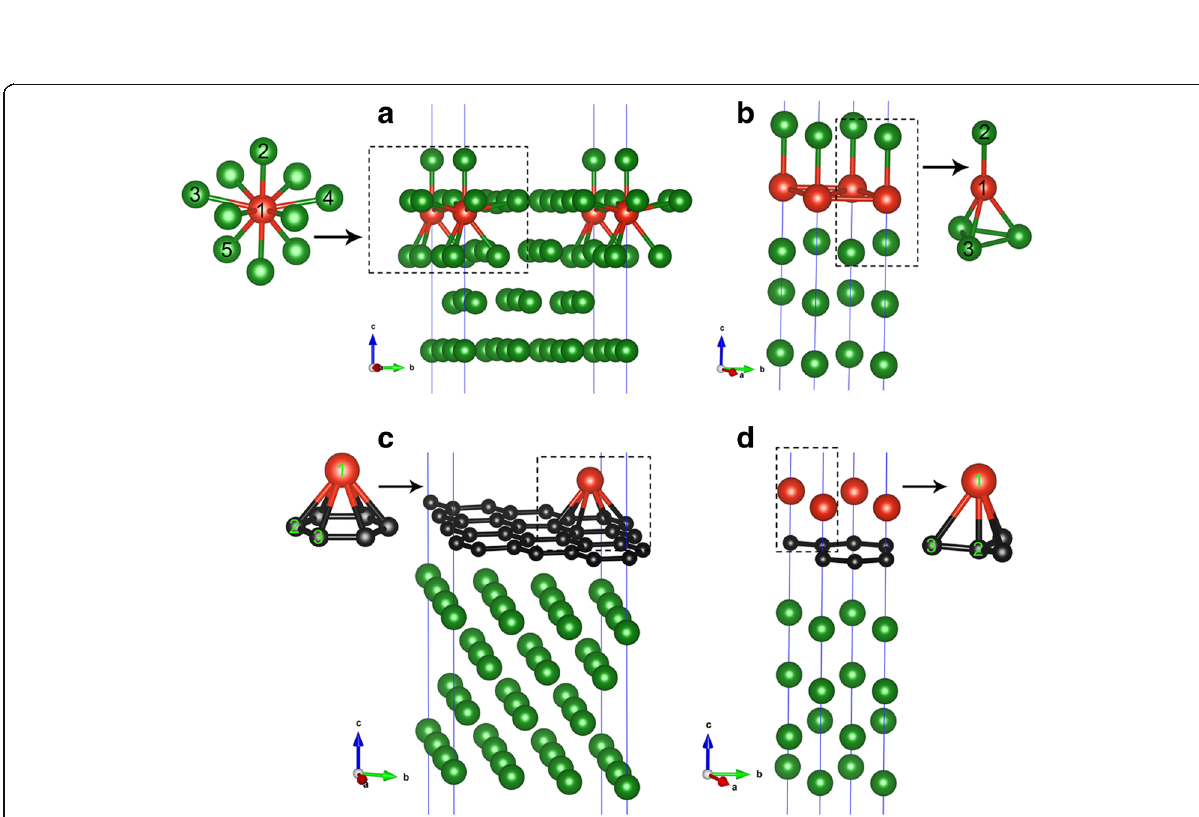
Fig. 2 Geometries of V/Cu(111) systems for a 1/9 ML and b 1 ML coverages. Geometries of V/Gra/Cu(111) systems for c 1/9 ML and d 1 ML coverage of V atoms. Red, black, and green balls represent V, C, and Cu atoms,